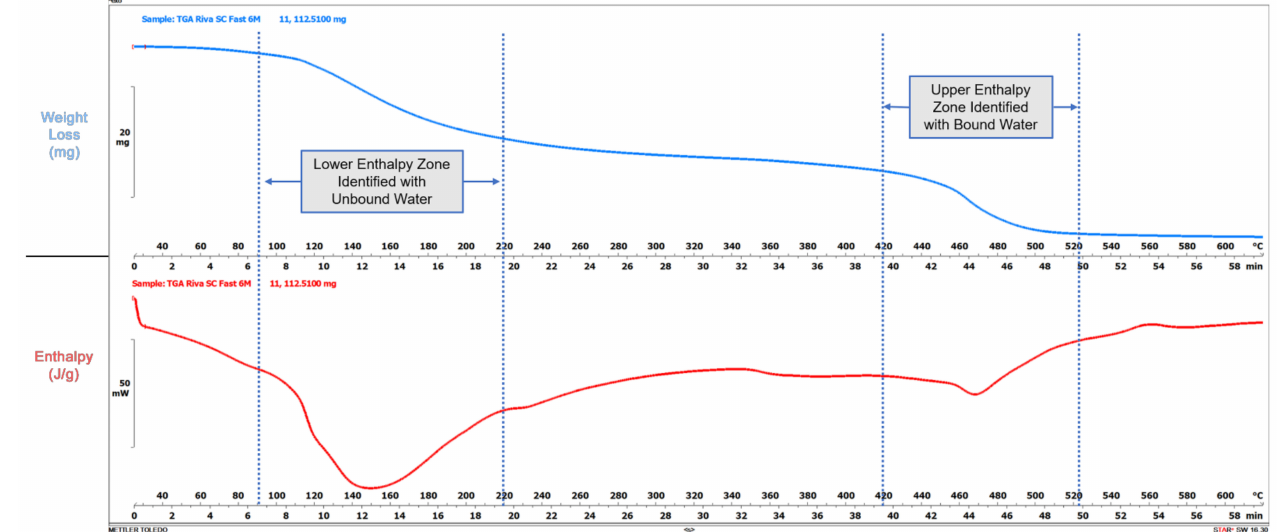
Figure 1. Thermal Analysis Protocol with Enthalpy Zones